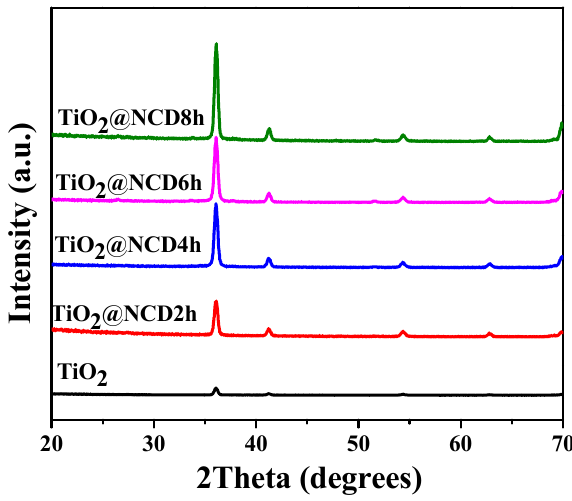
Figure 3. XRD patterns of TiO 2 and TiO 2 @NCD2h-8h.